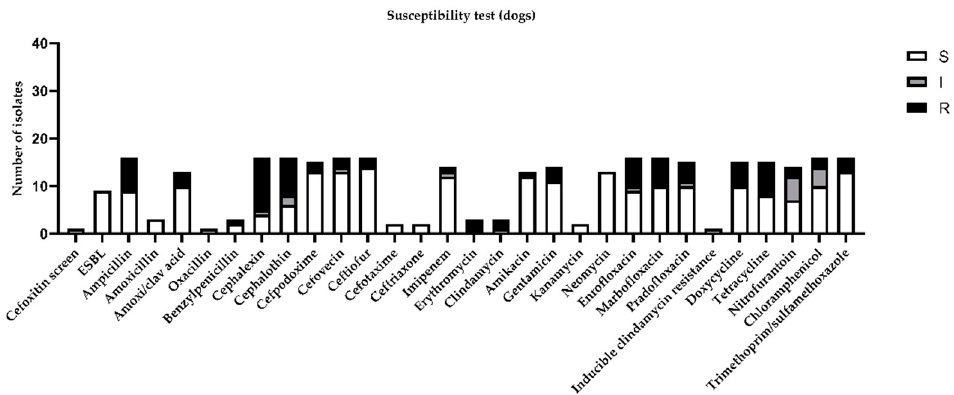
Figure 2. Figure represents sensitivity (S), intermediate (I), or resistance (R) to different antimicrobial drugs tested in susceptibility test, according to minimal inhibitory concentration (MIC) values considered by CLSI guidelines [11].